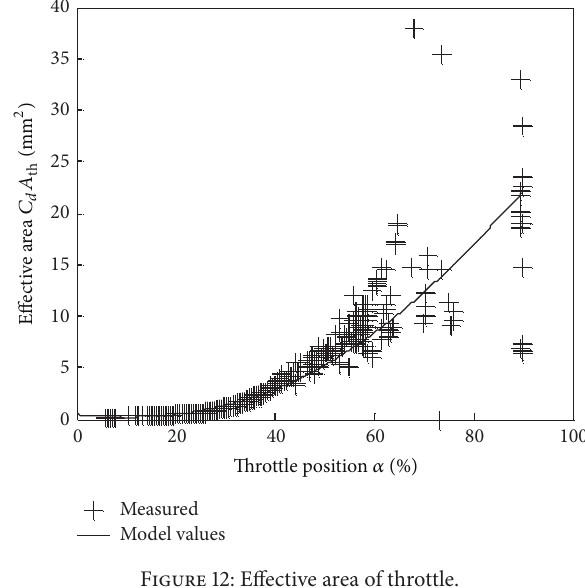
Figure 12: Effective area of throttle.